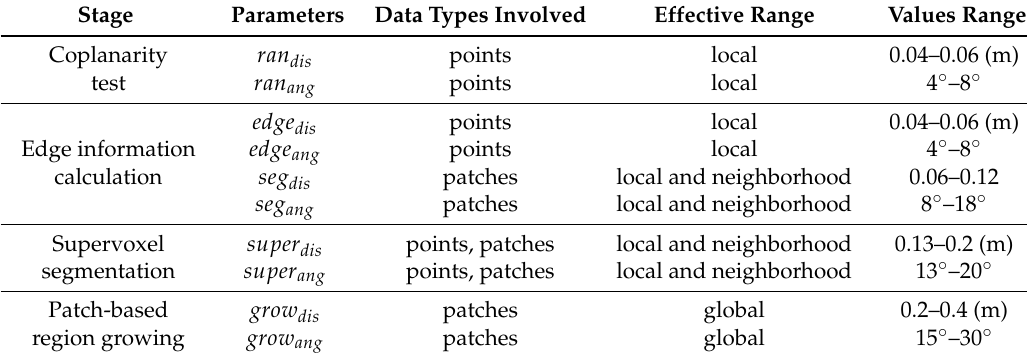
Table 2. Information of